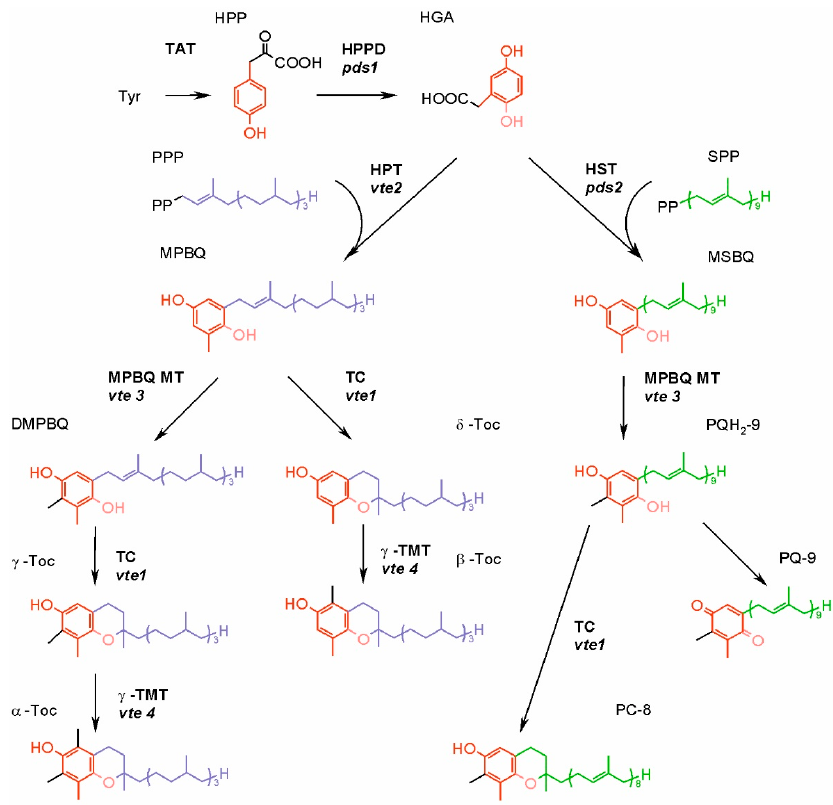
Figure 4. Synthesis of tocopherols, plastoquinone and plastochromanol-8 in higher plants. The mutants of genes encoding enzymes of Arabidopsis are given in italics. DMPBQ, 2,3-dimethyl- 6-phytyl-1,4-benzoquinone; HGA, homogentisic acid; HPP, p -hydroxyphenylpyruvate; HPPD, p - hydroxyphenylpyruvate dioxygenase; HPT, homogentisate phytyltransferase; HST, homogenti- sate solanesyl transferase; MPBQ, 2-methyl-6-phytyl-1,4-benzoquinone; MPBQ MT, 2-methyl-6- phytyl-1,4-benzoquinone methyltransferase; MSBQ, 2-methyl-6-solanesyl-1,4-benzoquinone; PC-8, plastochromanol-8; PQ-9, plastoquinone-9; PQH 2 -9, plastoquinol-9; PPP, phytyl pyrophosphate; SPP, solanesyl pyrophosphate; TAT, tyrosine aminotransferase; TC, tocopherol cyclase; γ -TMT, γ